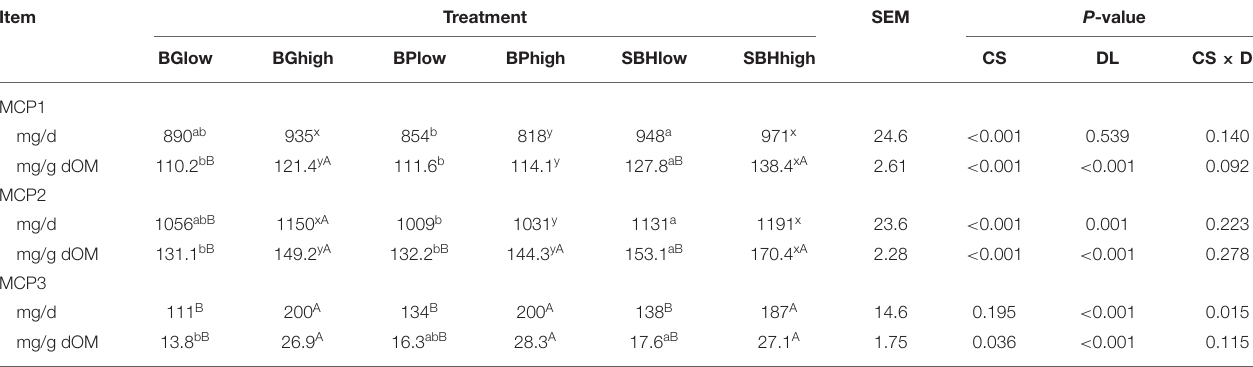
TABLE 3 | In vitro microbial crude protein (MCP) formation of different carbohydrate sources incubated at high and low dilution rate estimated using three different